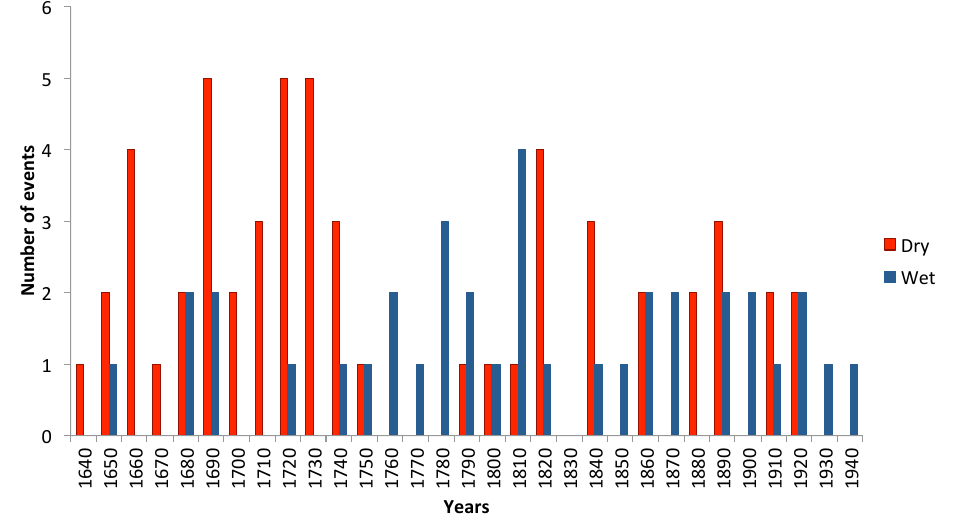
Figure 5. Number of dry and wet events per decade based on information from city and municipal council records; Claxton (1986, 1998) and Pardo